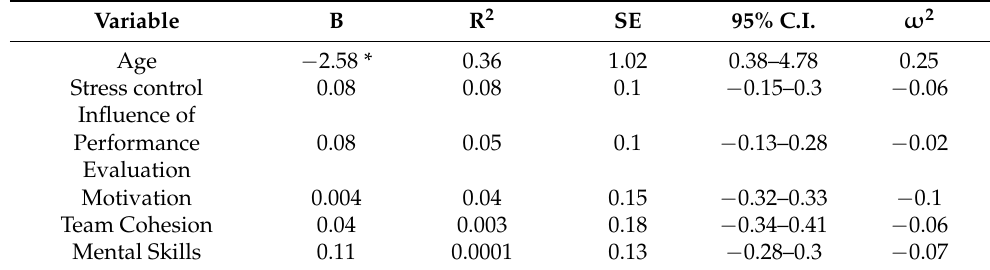
Table 2. Regression coefficients of the linear regression models for the variable championship (continuous variables) adjusted by years of rowing